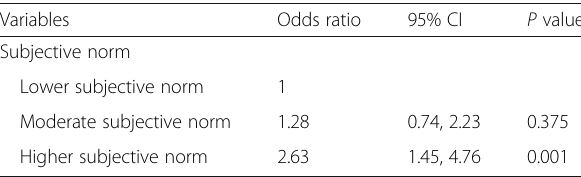
Table 3 Multivariate analysis with frequency of changing sanitary napkins in school toilets